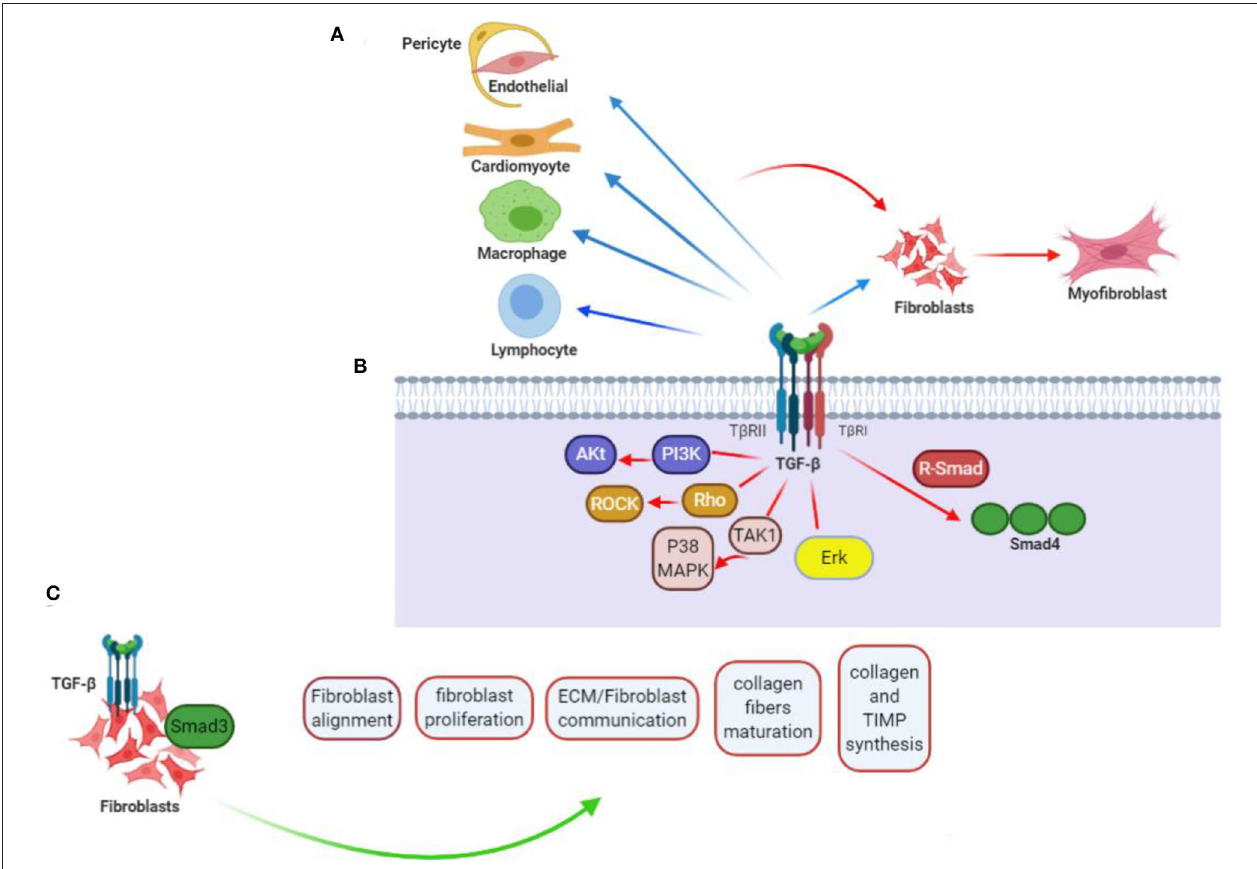
FIGURE 1 | TGF- β contribution to cardiac fibrotic events. (A) TGF- β affects phenotype along with operation in every cell somehow engaged in myocardial fibrotic event. Straightforward effects on conversing fibroblast (F) to myofibroblast (MF) and activating myofibroblast can be probably of more importance, but fibrogenesis caused by TGF- β s can further relate with its impacts on the phenotype of macrophage (Ma), differentiation and function of lymphocyte (L), and cardiomyocyte (CM) viability, as well as gene expression. Apart from that, TGF- β can encourage pericyte (P) to fibroblast transformation and endothelial-to-mesenchymal transdifferentiation, when induced by vascular cells to express fibrosis-associated genes. (B) TGF- β s regulate phenotypes of the cells through activation of Smad-related together with non-Smad signaling pathways. (C) TGF- β /Smad3 signaling effect on CFs. Current researches taking advantage of loss-of-function procedures associated with specific cells drew conclusion that activating Smad3 contributes significantly to the formation of organized myofibroblast arrays after myocardial infarction. Lack of Smad3 in fibroblasts deranges infarcted heart reparations, resulting in higher risks of late cardiac rupture and undesirable chamber dilation. The evidence points out the reparative operation of fibroblasts activated in the infarcted myocardium. Mediation of the Smad3 effects is being carried out by the integrin–ROS axis arousal. This figure was adapted from Frangogiannis